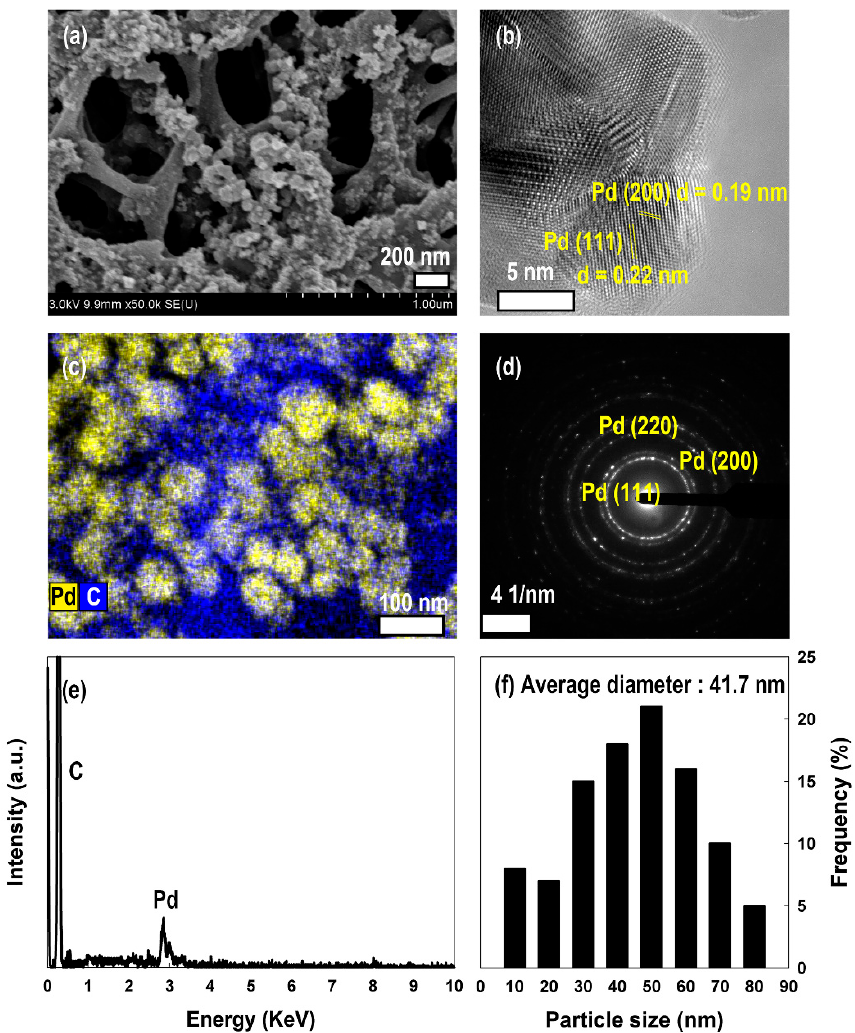
Figure 5. ( a ) SEM image, ( b ) TEM image, ( c ) EDS elemental mapping image, ( d ) SAED pattern, and ( e ) EDS spectrum of Pd 0.5/APCF_H 0.3. ( f ) Diameter distribution of Pd nanoparticles in the sample, Pd0.5/APCF_H 0.3.